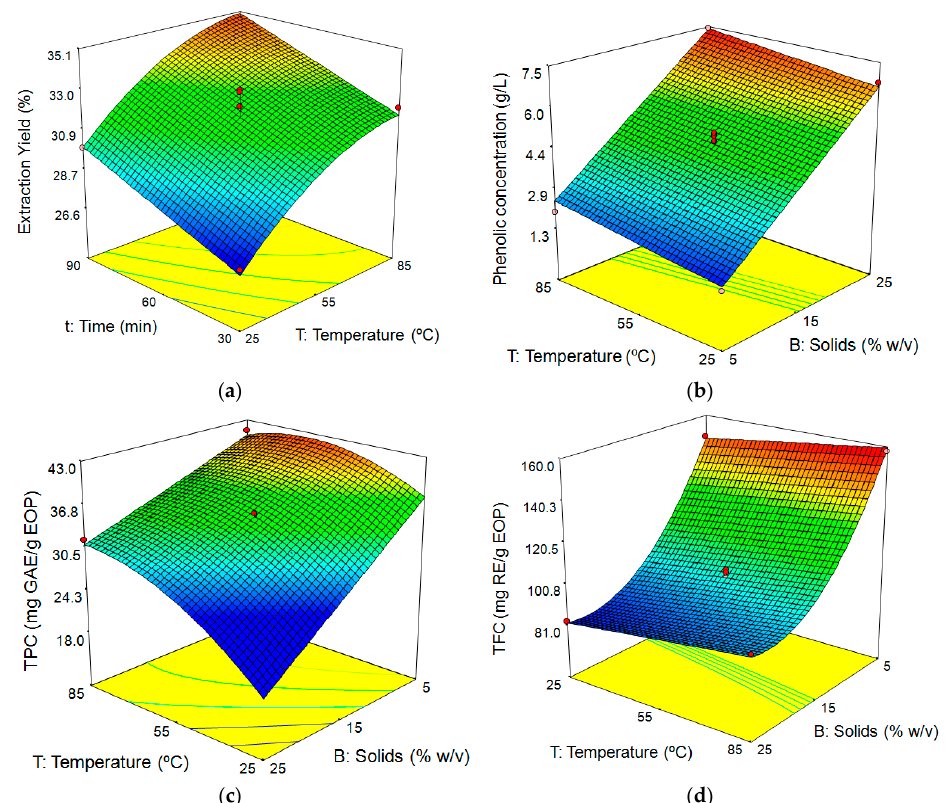
Figure 1. Response surfaces for ( a ) extraction yield as a function of temperature and time at 15% solids, ( b ) phenolic concentration, ( c ) TPC, and ( d ) TFC as a function of temperature and solid loading (extraction time: 60 min).